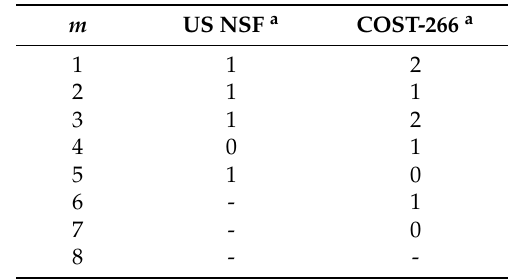
Figure 4. The COST-266 European network (topologically, not geographically, accurate). Table 1. Comparing AlgR with known optima.